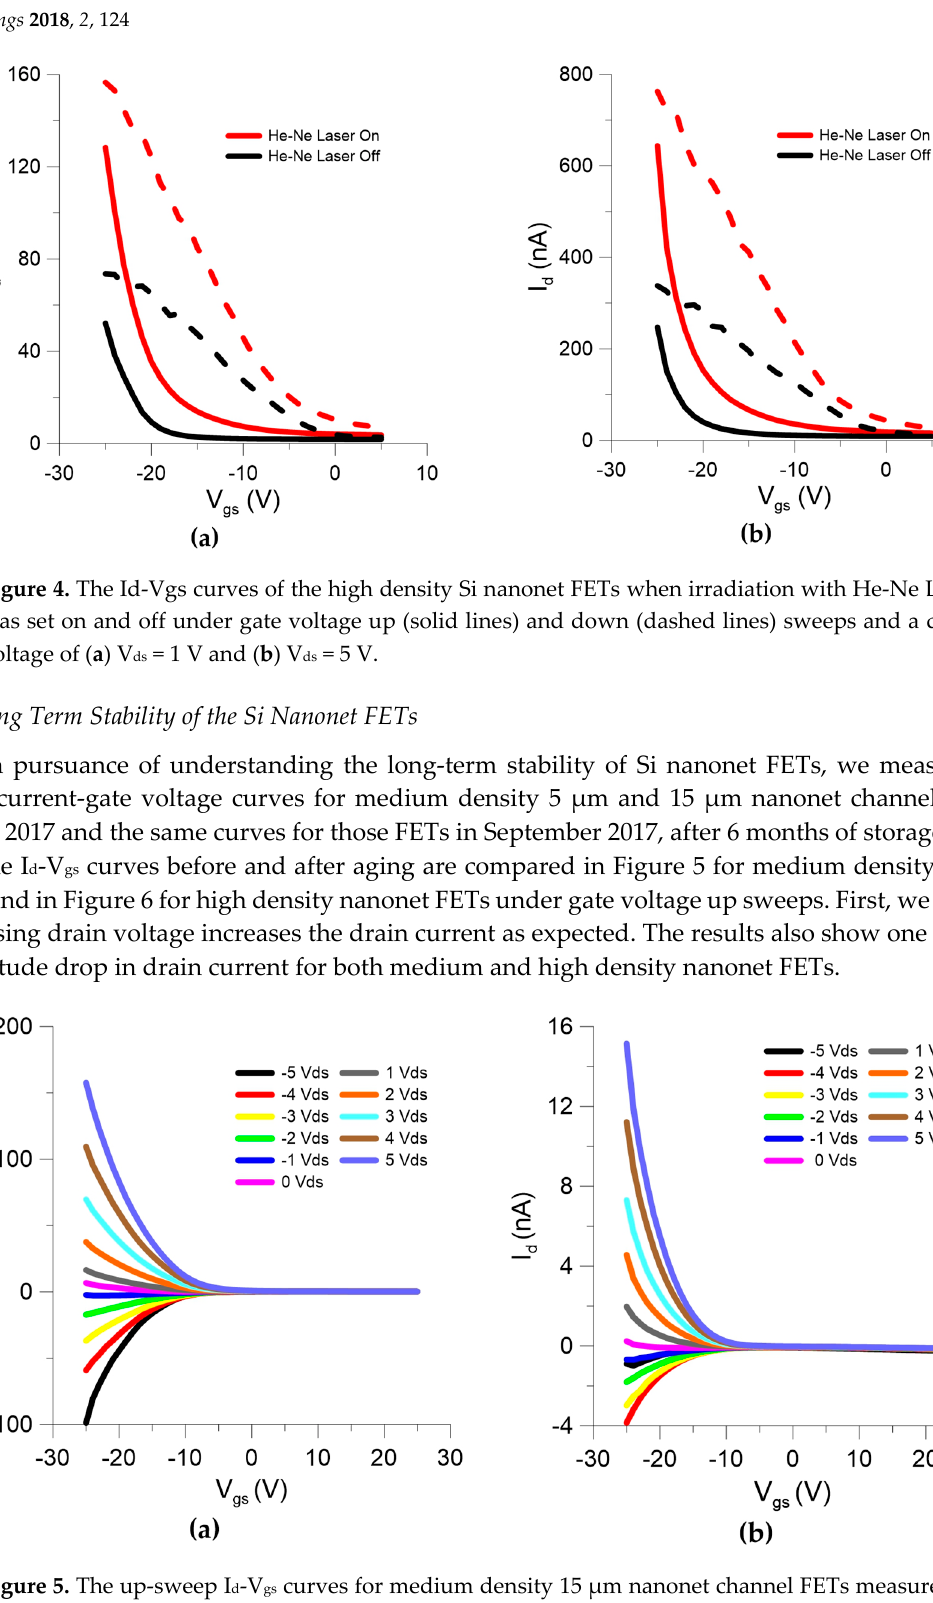
Figure 5. The up-sweep I d -V gs curves for medium density 15 µm nanonet channel FETs measured in ( a ) March and ( b ) September